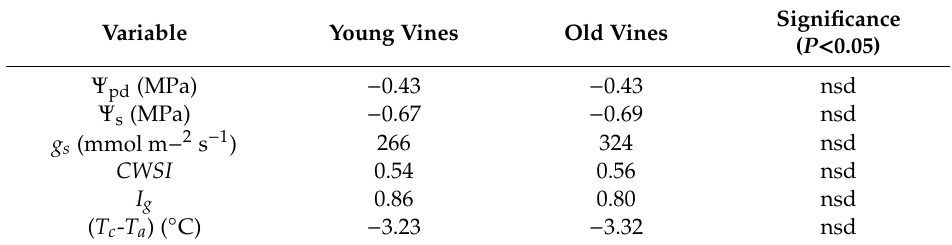
Table 3. Comparison of CAS vine water status of old (> 40 years old) versus young (< 10 years old) vines for the 2017 season at pre-harvest (S2, F2).